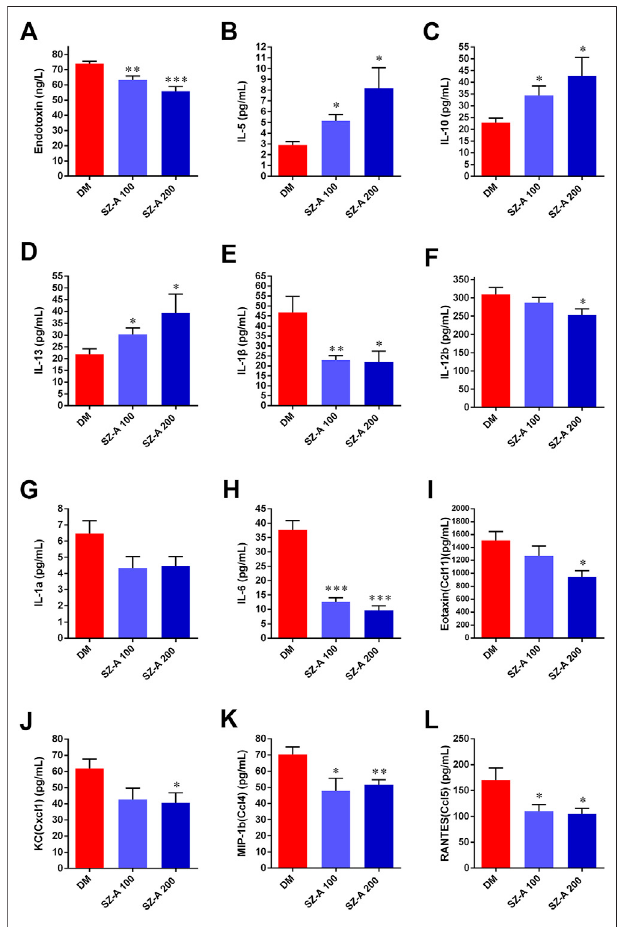
FIGURE 5 | SZ-A improves in fl ammatory status in KKAy mice. (A) IL-5, (B) IL-10 (C) IL-13, (D) IL-1 β , (E) IL-1a, (F) IL-6, (G) IL-12b, (H) Eotaxin (Ccl11), (I) KC(Cxcl1), (J) MIP-1b (Ccl4), (K) RANTES (Ccl5) and (L) Endotoxin. Data are expressed as the mean ± SEM, n (cid:1) 8. * p < 0.05, ** p < 0.01, *** p < 0.001 vs . DM. DM, diabetic model group, SZ-A 100, SZ-A low-dose-treated group, SZ-A 200, SZ-A-high-dose-treated